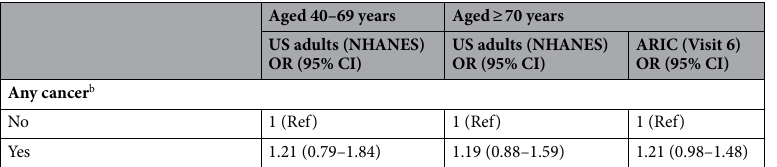
Table 3. Age-, sex-, and race-adjusted odds ratios [OR (95% CI)] for the association of risk factors with peripheral neuropathy in US adults aged 40–69 and ≥ 70 years (NHANES, 1999–2004) and ARIC participants aged ≥ 70 years (Visit 6, 2016–2017). a Odds ratios are among participants who were not missing data for peripheral artery disease: N = 3215 in NHANES aged 40–69 years, N = 1204 in NHANES aged ≥ 70 years, and N = 2971 in ARIC visit 6. b Odds ratio for ARIC is among participants who were not missing cancer status in ARIC visit 6, N =